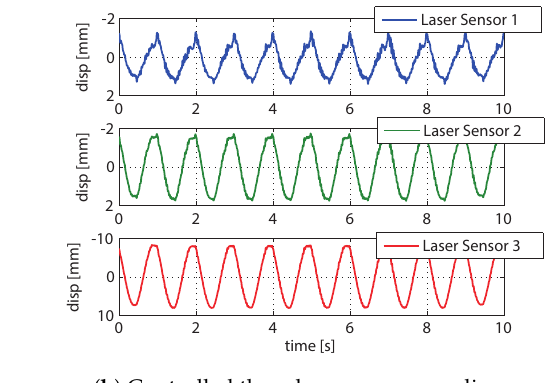
( b ) Controlled three laser sensors readings Figure 12. Controlled: 1 Hz sinusoidal